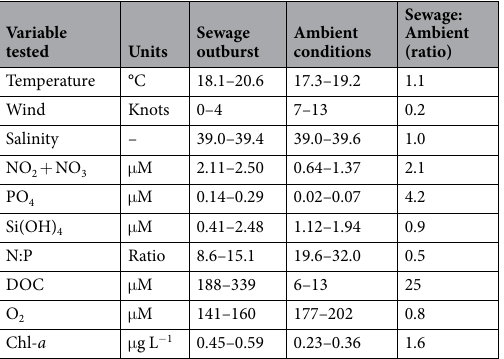
Table 1. The physiochemical and biological characteristics of the SEMS coastal water during a sewage outburst event and during typical wintertime (ambient)